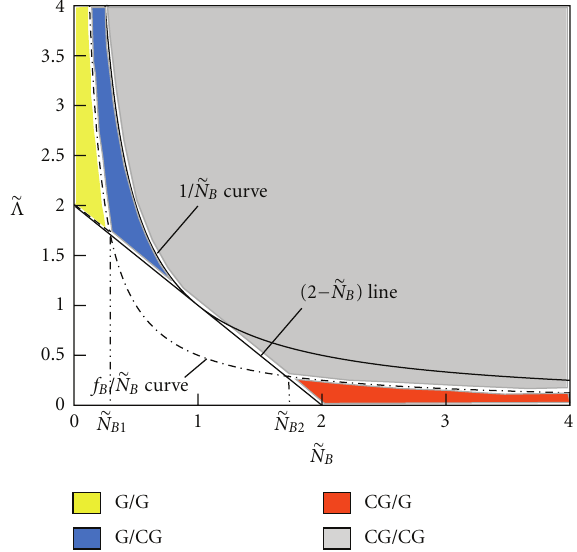
Figure 4: The domain of the three di ff erent possibilities for the turbulent flame brush structure in the plane ( (cid:2) Λ , (cid:2) N B ) for f B >